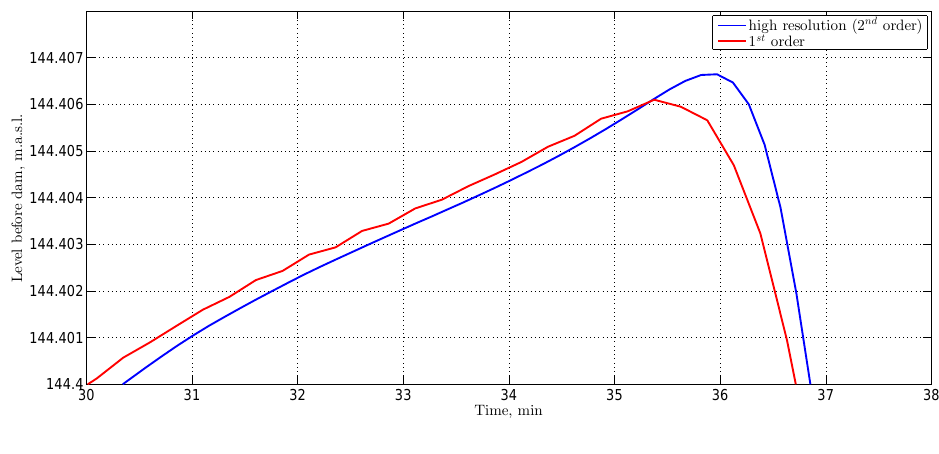
Figure 8: Zoomed plot of the water level ahead of the Grønvollfoss dam (ode23t